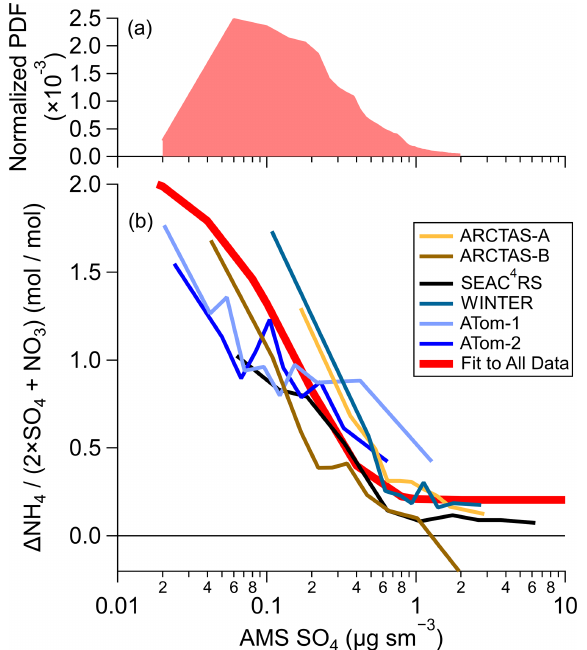
Figure 4. (a) Predicted normalized probability distribution function (PDF) for tropospheric (pressure > 250hPa) sulfate from GEOS- Chem for 1 model year (see the Supplement). (b) Difference be- tween SAGA and AMS ammonium (molsm − 3 ) divided by AMS sulfate and nitrate (molsm − 3 ) versus AMS sulfate (µgsm − 3 ) for the six different airborne campaigns. The values shown are binned deciles for the six different airborne campaigns. The fit shown in (b) is for all data from all